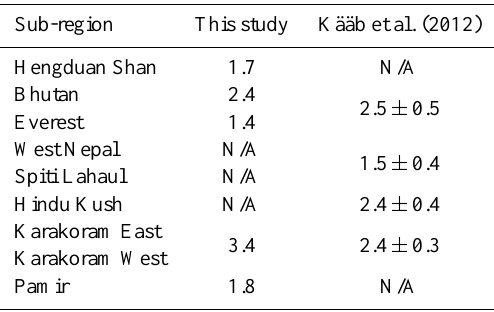
Table 3. Average SRTM C-band penetration estimates (in m) in February 2000 over glaciers in this study and from Kääb et al.